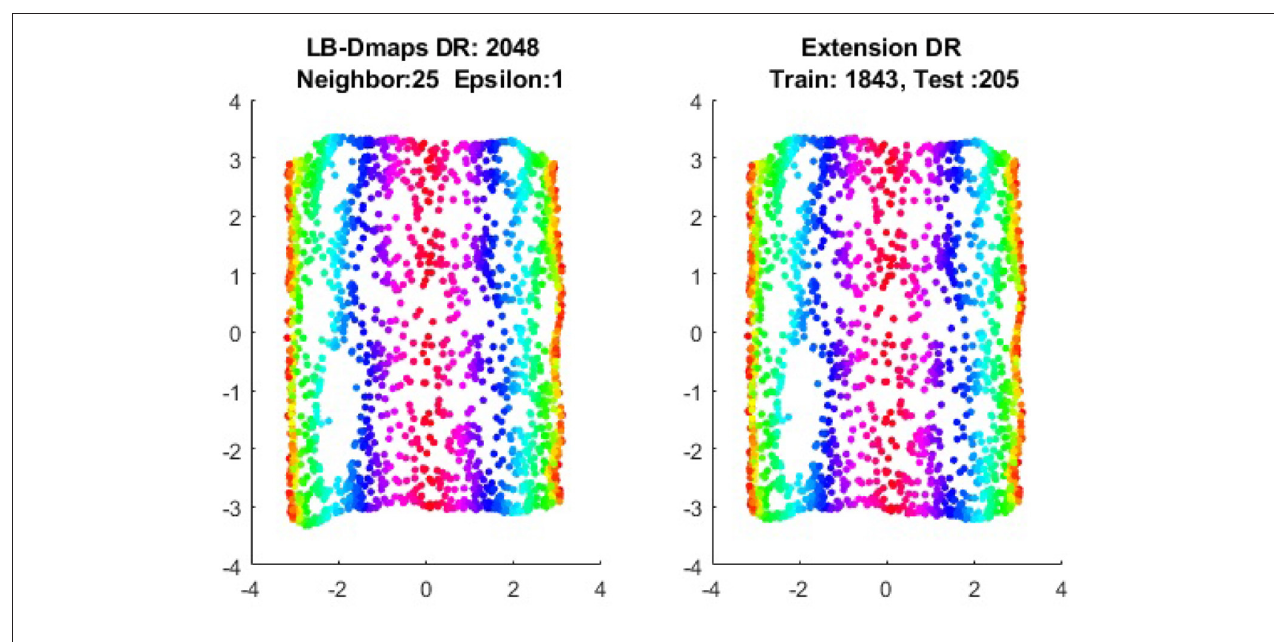
FIGURE 6 | LB out-of-sample extension for DR of S-Curve.